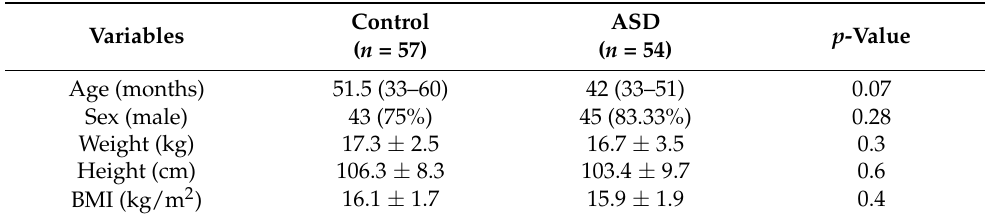
Table 1. Demographic and anthropometric characteristics of the group of children with autism spectrum disorders and the control healthy group.